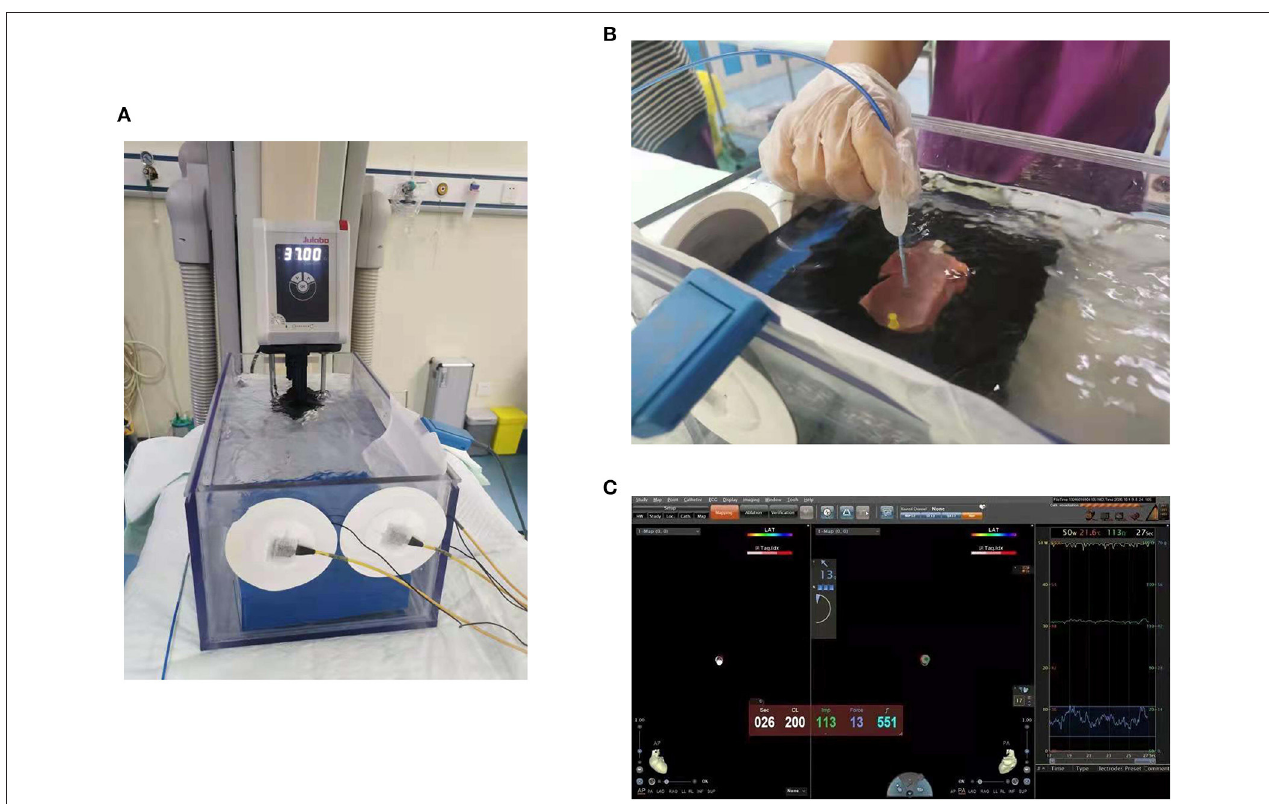
FIGURE 1 | An ex vivo experimental model. (A) This model consisted of saline with a circulating pump with the temperature maintained at 37 ◦ C. (B) The approach that manually fixed the catheter so that it met the tissue to produce the corresponding catheter force. (C) The catheter stability using the CARTO3 system.